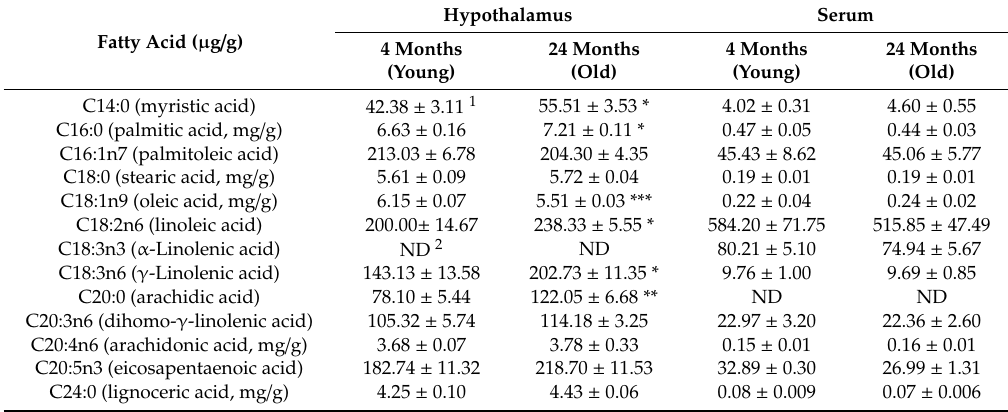
Table 1. Composition of fatty acids in hypothalamus and serum of young and aged mice. Fatty Acid ( µ g / g)